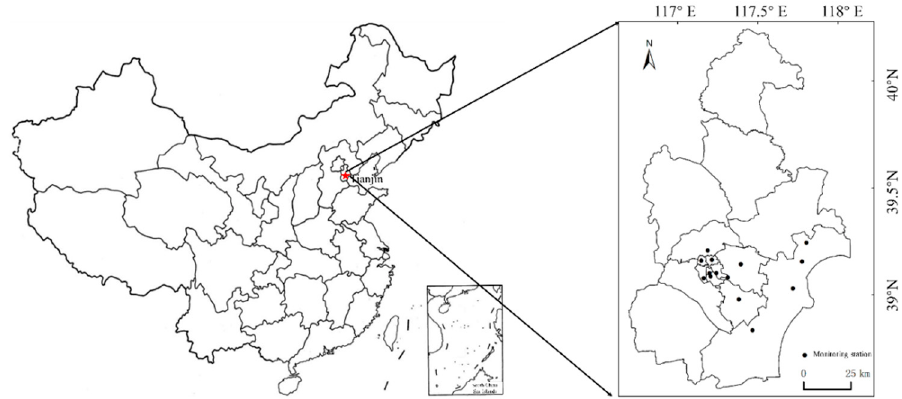
Figure 1. The national air quality monitoring station in Tianjin.